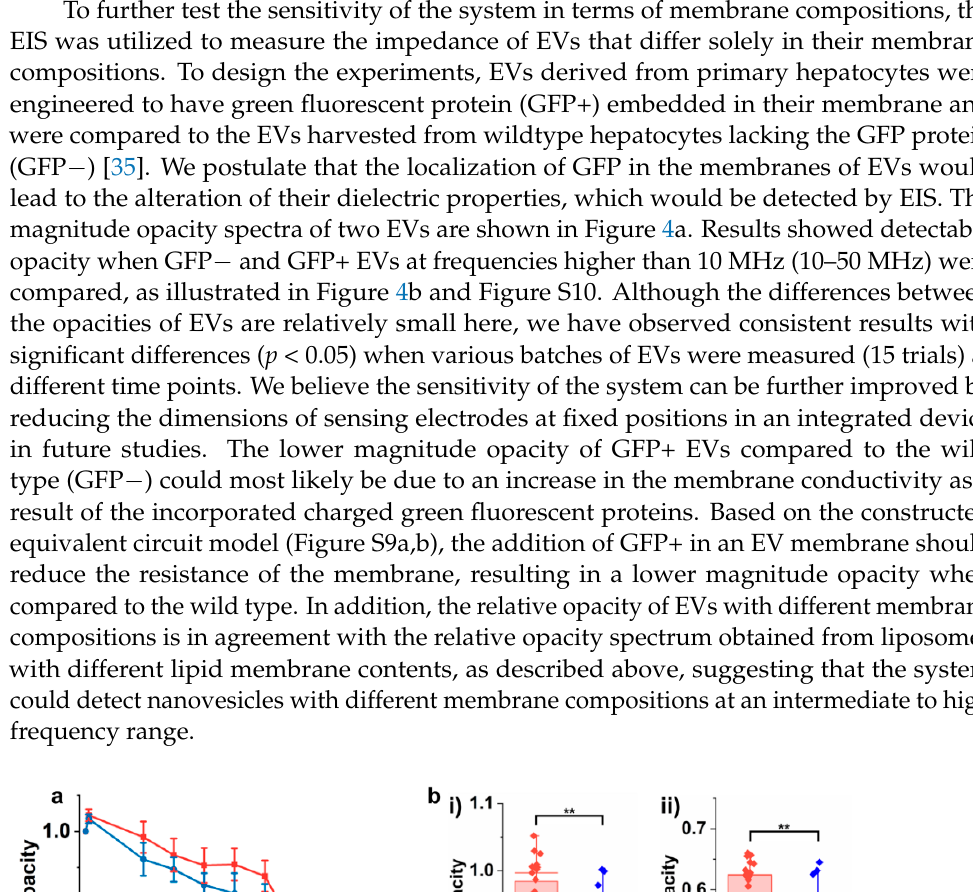
Figure 3. ( a ) Schematic representations of two types of liposomes with different membrane compo- sitions (CH:PC (1:10) and CH:PC (10:1) ). The relative magnitude opacity of liposomes and COOH-PS beads (the average size of all particles is 100 nm) utilizing ( b ) the mathematical model and ( c ) the experimental measurement. (n = 15.)